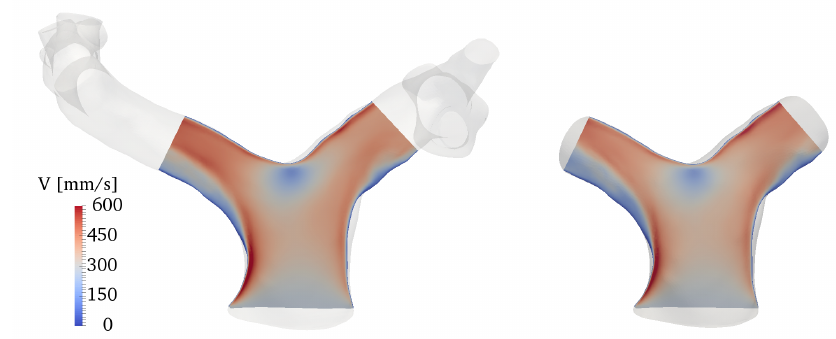
Figure A2. Comparison of ensemble-averaged velocity magnitude along a slice cutting the domain at the branches centerline. The full model is reported on the left, the cropped model on the right.